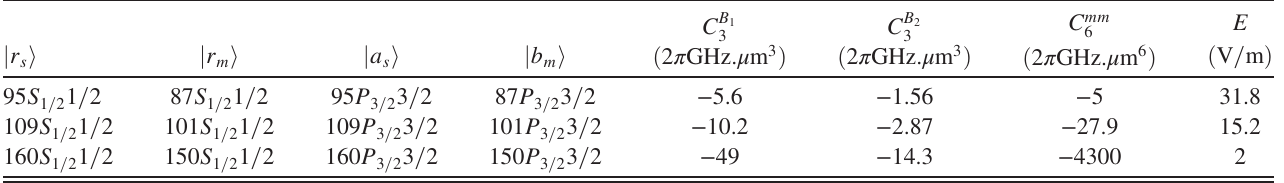
TABLE I. Two Rydberg atom pairs j r s r m i and j a s b m i are in resonance in the presence of a static external field E . The multiqubit state is represented by the subscript m , associated with k control (target) qubits in the C k -NOT (C-NOT k ) gate. The single-qubit state is represented by the subscript s . The interaction coefficients of states j r s r m i , j r m b m i , and j r m r m i are represented by C B 1 3 , C B 2 3 , and C mm 6 ,